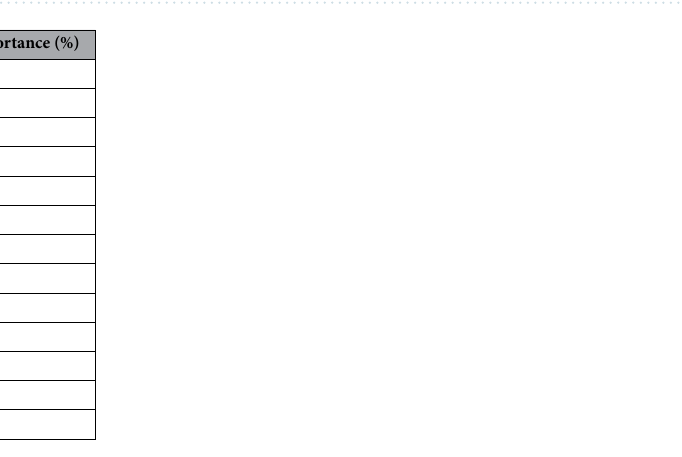
Table 3. Table showing the percentage of variation each principal component (PC) accounts for first seven PC function (marked as bold) contributed 94.8% in describing the variable.